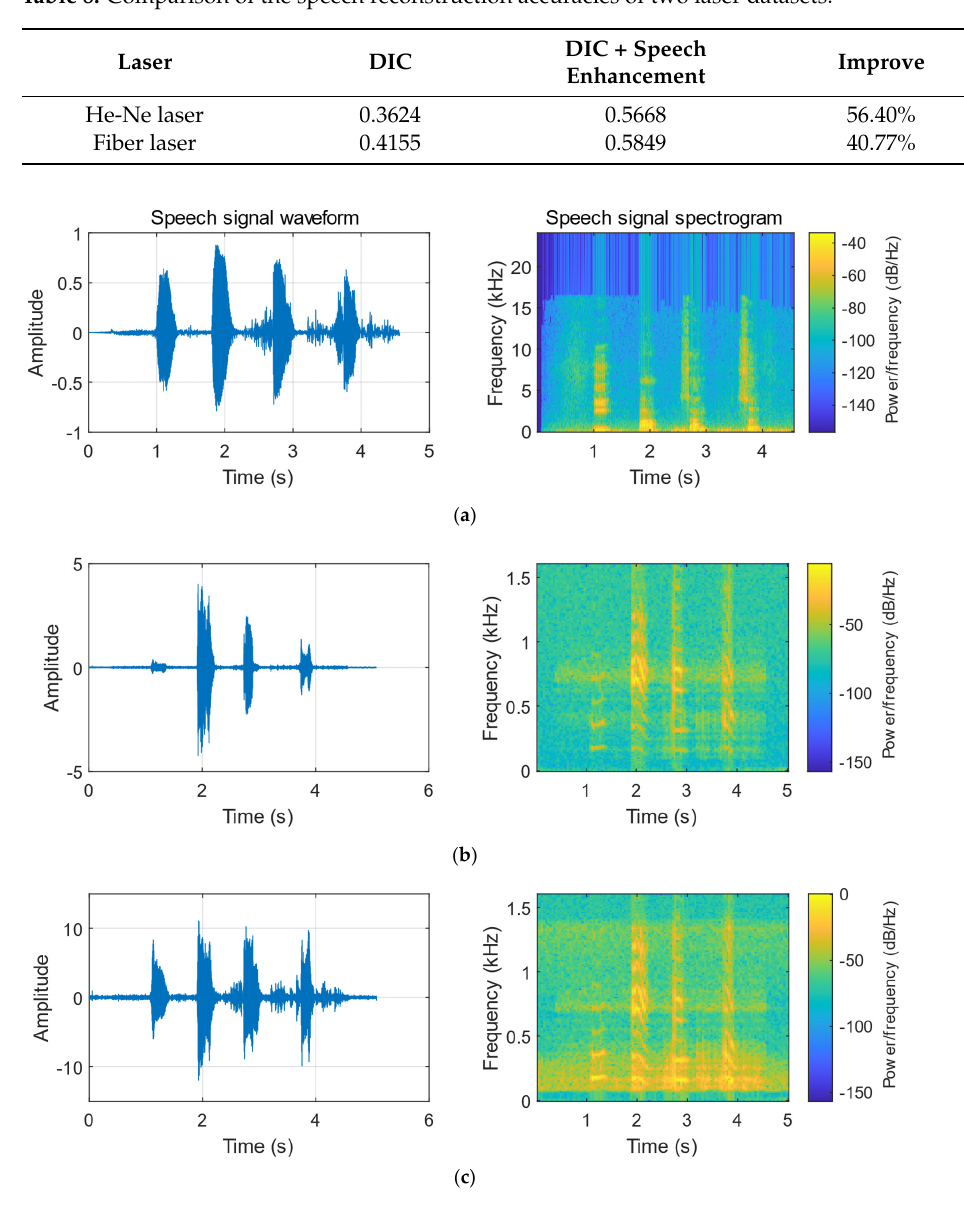
Figure 14. Comparison of speech signals reconstructed using the He ‐ Ne Laser. ( a ) Original speech signal. ( b ) Speech signal reconstructed by DIC. ( c ) Speech signal reconstructed by DIC + speech enhancement.